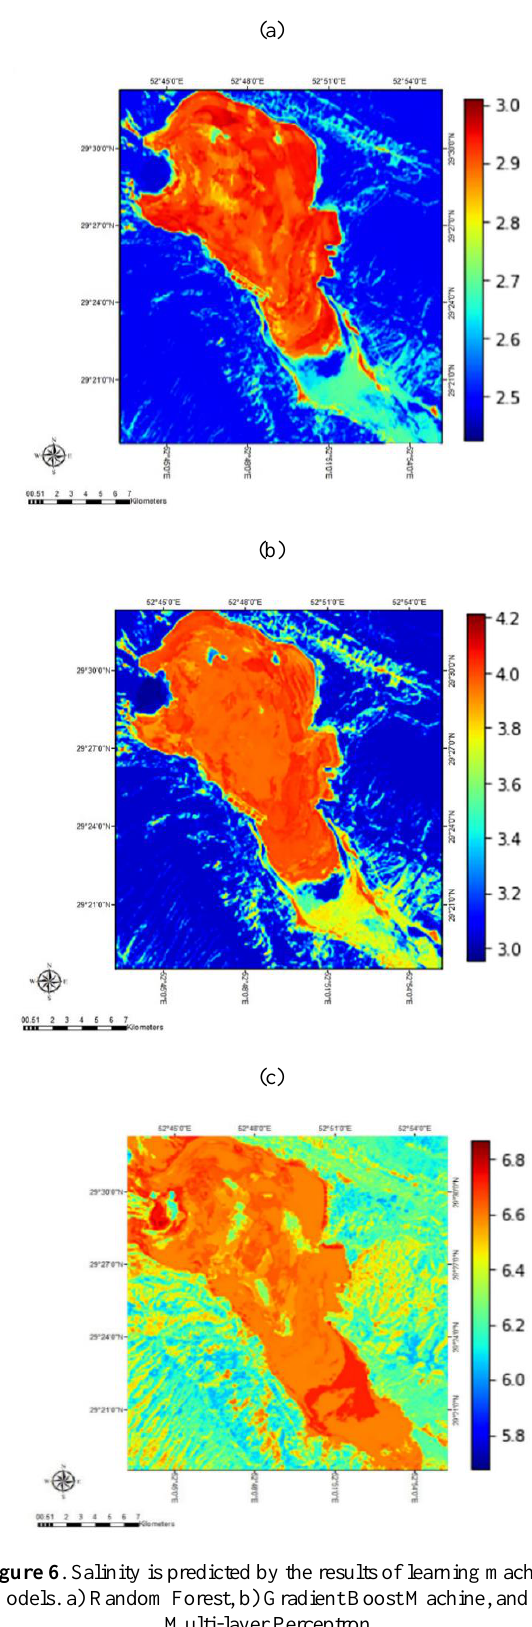
Figure 6 . Salinity is predicted by the results of learning machine models. a) Random Forest, b) Gradient Boost Machine, and c) Multi-layer